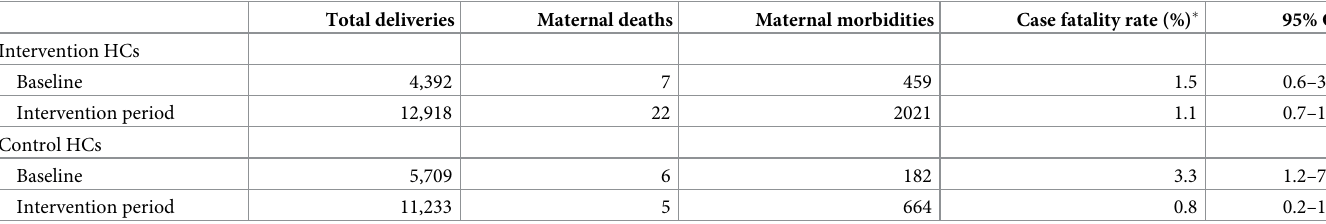
Table 2. Obstetric case fatality rate before and after the intervention in the control and intervention health centres. Total deliveries Maternal deaths Maternal morbidities Case fatality rate (%) � 95% CI Intervention HCs Baseline 4,392